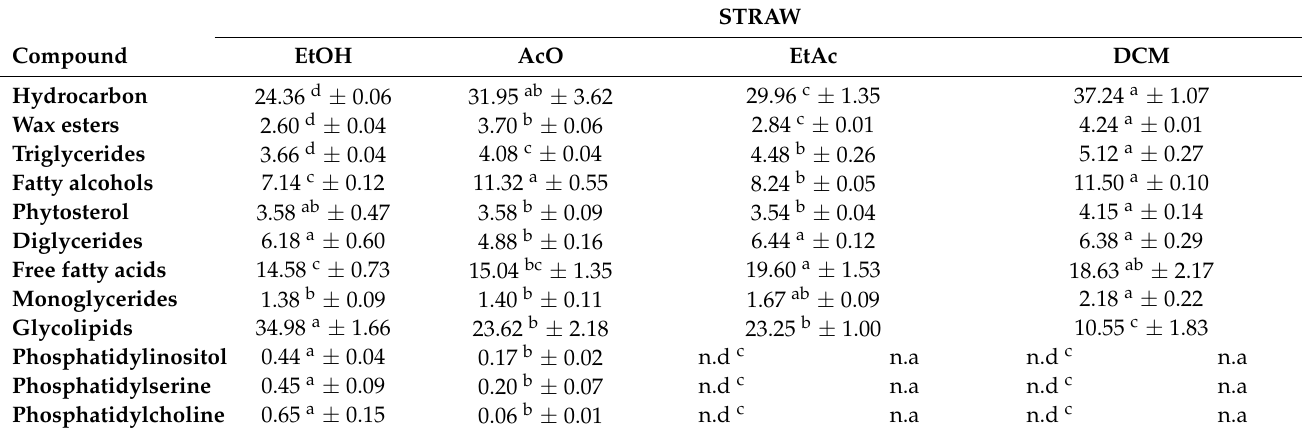
Table 1. Lipid classes composition (g/100 g of lipids) of different sugarcane straw extracts. STRAW